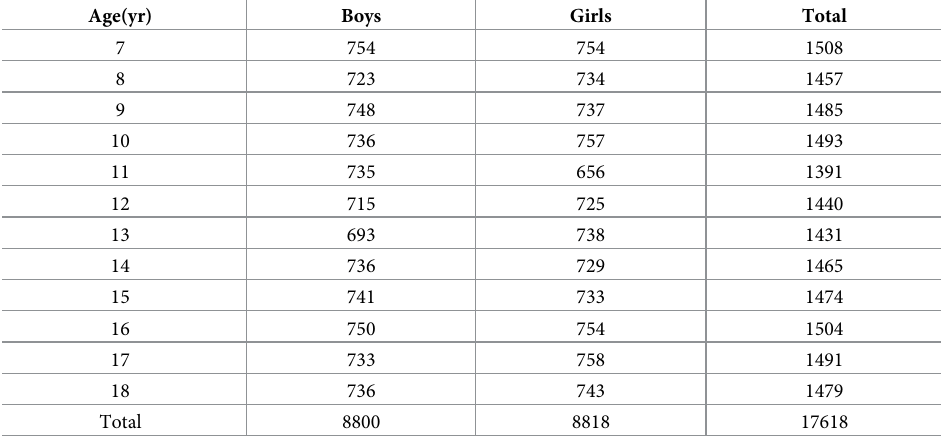
Table 1. Gender distribution by age in participating children and adolescents from Xinjiang,